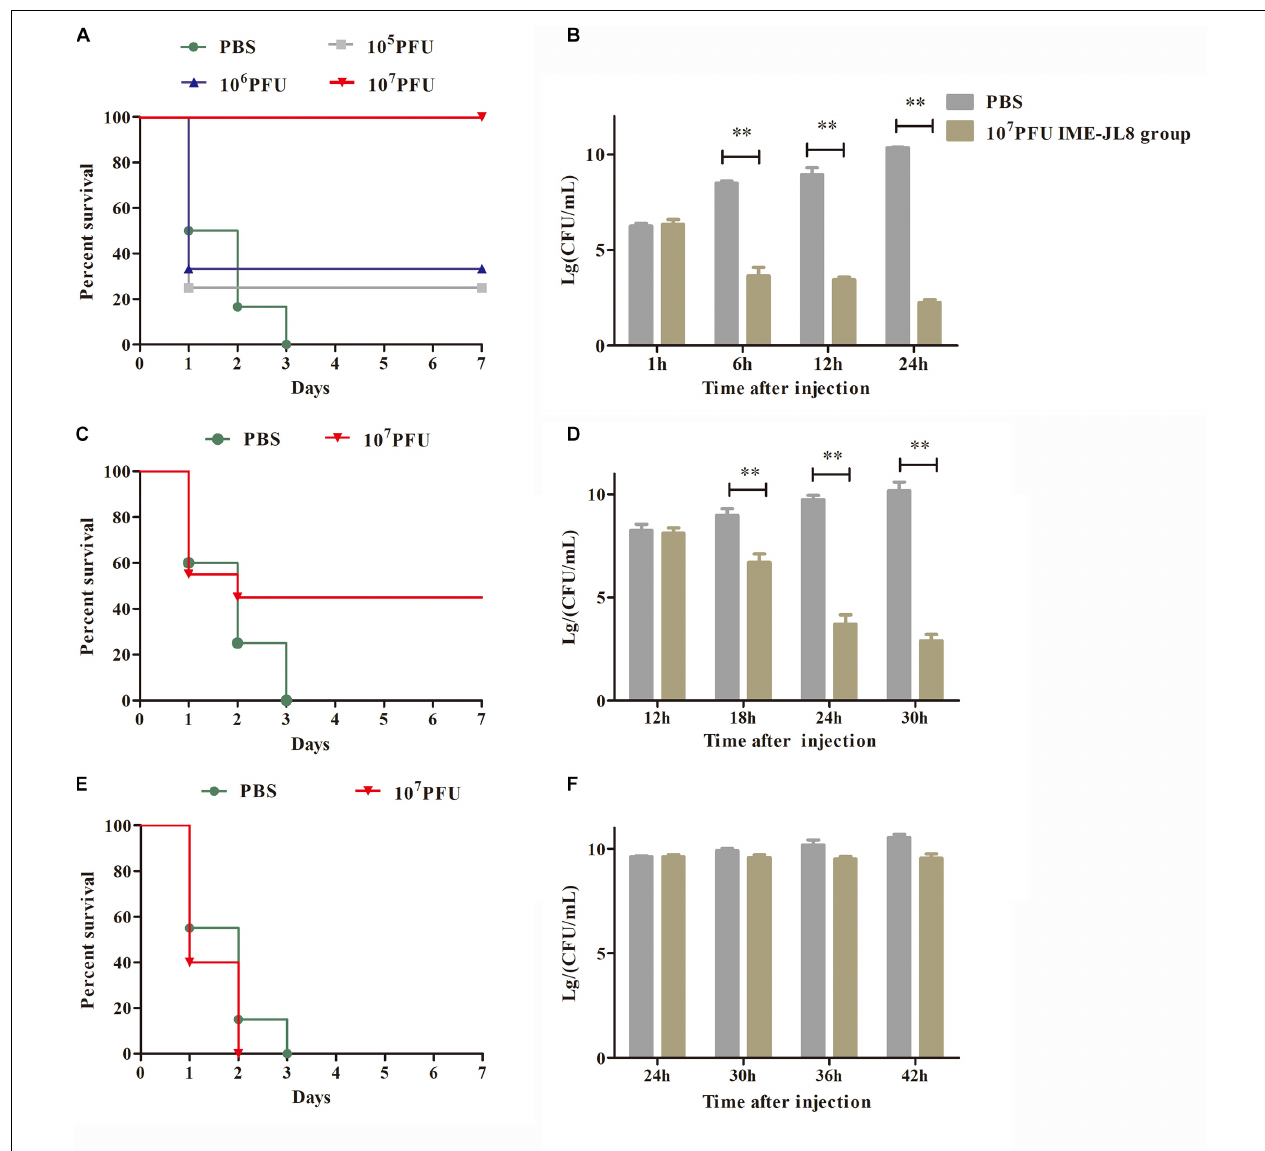
FIGURE 6 | IME-JL8 therapeutic study. The fish were intraperitoneal injection of 2 × minimum lethal dose (MLD) (2 × 10 9 CFU/carp) of C. freundii CF8. (A–E) Survival rate of different groups. One hours later, 10 5 , 10 6 , and 10 7 PFU of IME-JL8 were introduced intraperitoneal (A) . After injection of C. freundii CF8 (2 × 10 9 CFU/carp) 12 h later (C) , 24 h later (E) , 10 7 PFU phage of IME-JL8 were introduced intraperitoneal. Control fish were administrated with PBS under the identical conditions. (B,D,F) Colony counts of bacteria changed in the blood. After injection of C. freundii CF8 (2 × 10 9 CFU/carp) 1 h later (B) , 12 h later (D) , 24 h later (F) . colony counts of bacteria changed in the blood at regular intervals ( n = 6 in each group). Control fish were administrated with PBS under the identical conditions. The means and standard deviations are represented as points with error